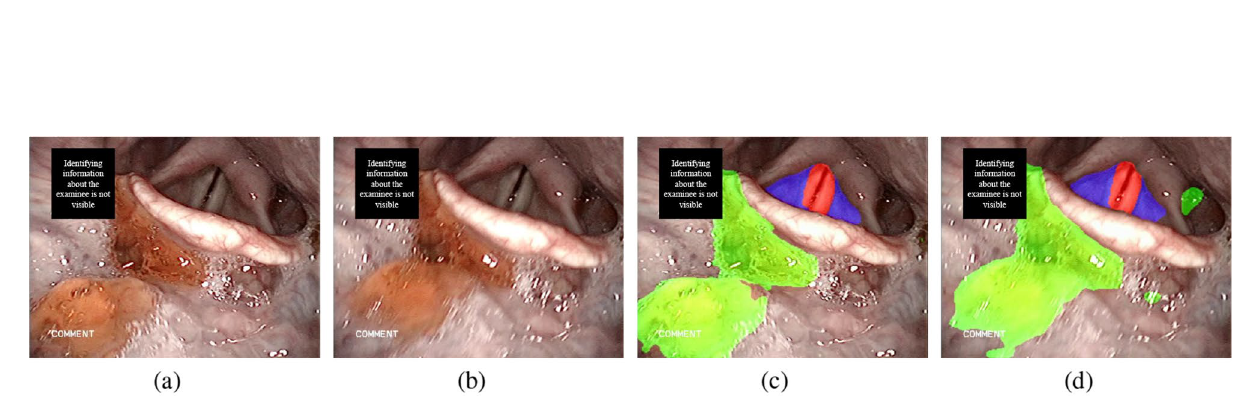
Figure 8. An example of two consecutive FEES images ( a ) and ( b ), and their corresponding segmentation results ( c ) and ( d ). Red: aspiration area, Purple: penetration area, and Green: test